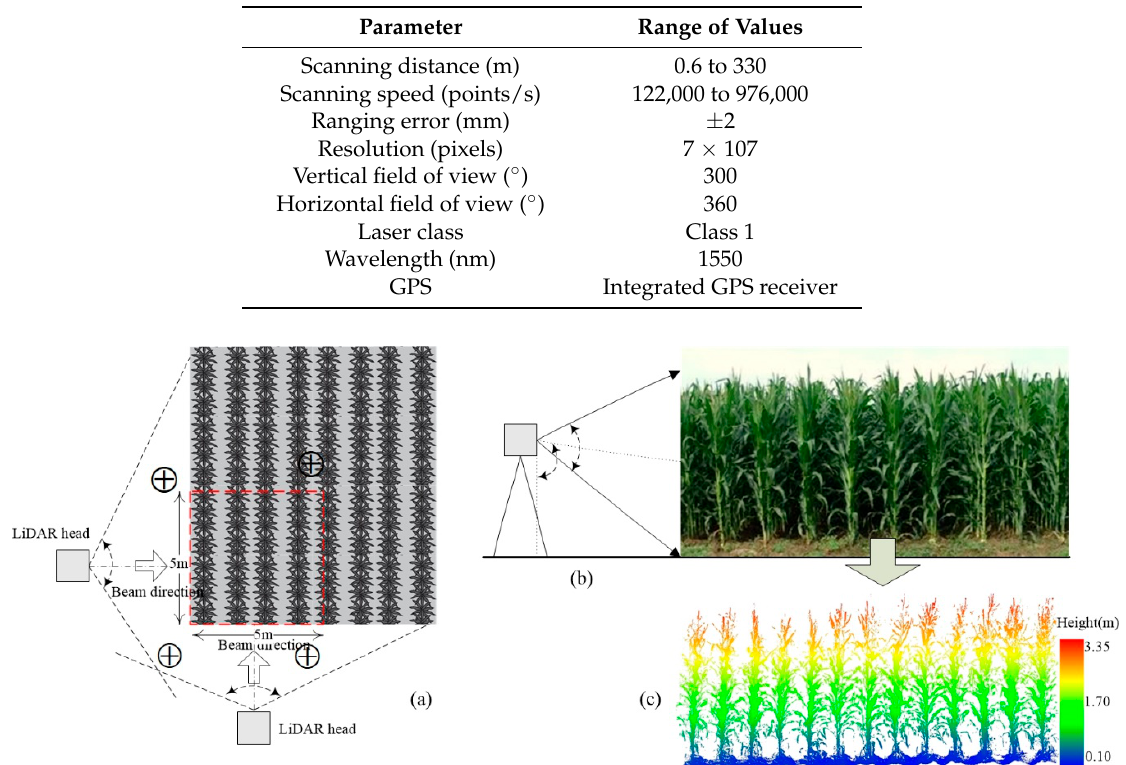
Figure 2. In-situ data collection activities conducted in each sampling plot: ( a ) obtaining a 3D image of the plot using the TLS scanner, ( b ) photographing the leaves for manual calculation of leaf angles, and ( c , d ) measuring LAI using the LI-COR LAI-2200C plant canopy analyzer. Table 1. The parameters of the FARO Focus3D X330 LiDAR surveying instrument.